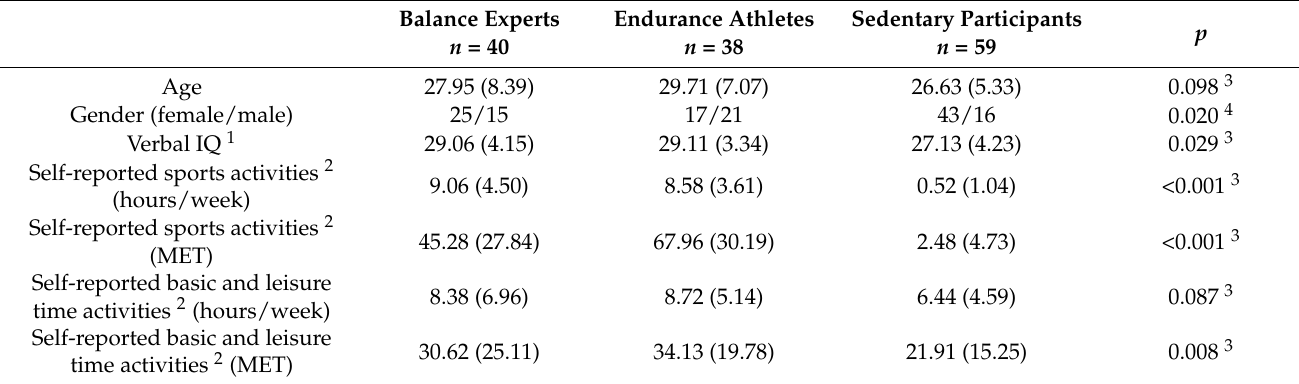
Table 1. Participant characteristics (Mean, Sd) for balance experts, endurance athletes and sedentary participants.